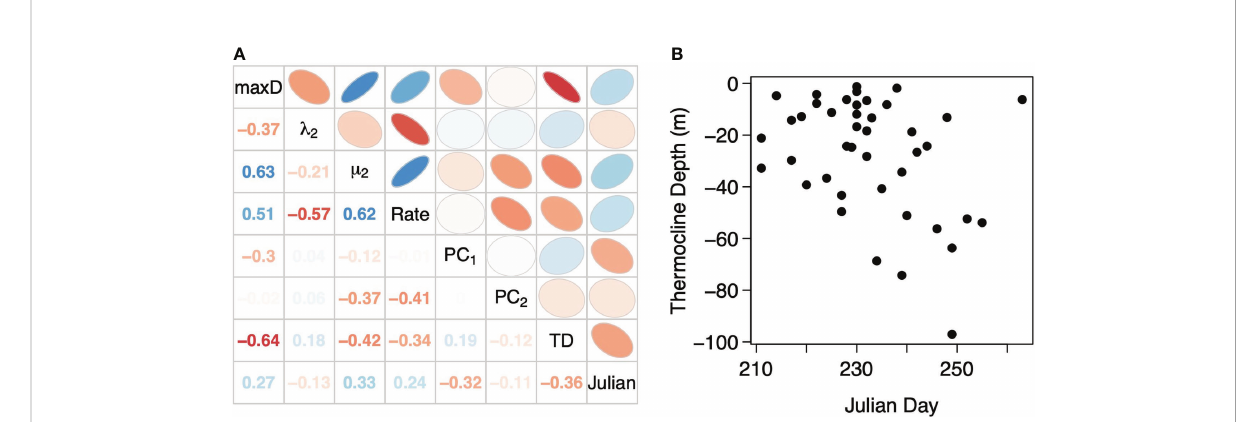
FIGURE 5 (A) Correlations between thermocline depth (TD), Julian day, and the vertical movement metrics: maximum depth in the deployment (max D), the percent time subsurface ( l 2 ), the mean depth of the subsurface component ( m 2 ), the subsurface movement rate in terms of movements per hour (Rate), as well as the score from the fi rst and second principal components (PC 1 and PC 2 ) of the PCA on the proportion of total subsurface movements in each shape cluster. (B) Thermocline depth derived from temperature pro fi les developed from the temperature logging on the basking shark deployed TDR tags as a function of Julian Day of the